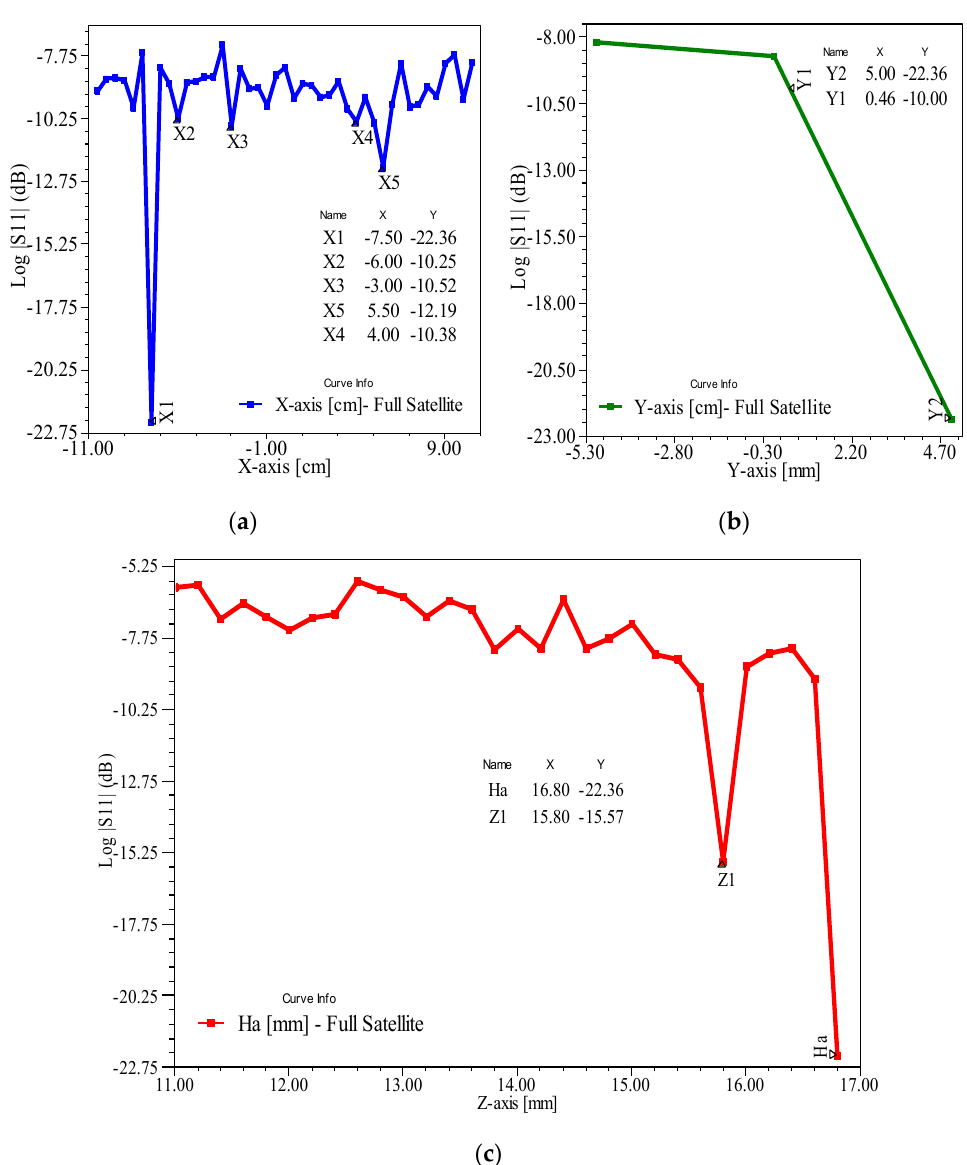
Figure 21. Reflection coefficient of the proposed full satellite at 2450 MHz: Proposed antenna + 3U CubeSat: ( a ): Reflection coefficient versus X-axis; ( b ): Reflection coefficient versus Y-axis; ( c ): Reflection coefficient versus Z-axis.